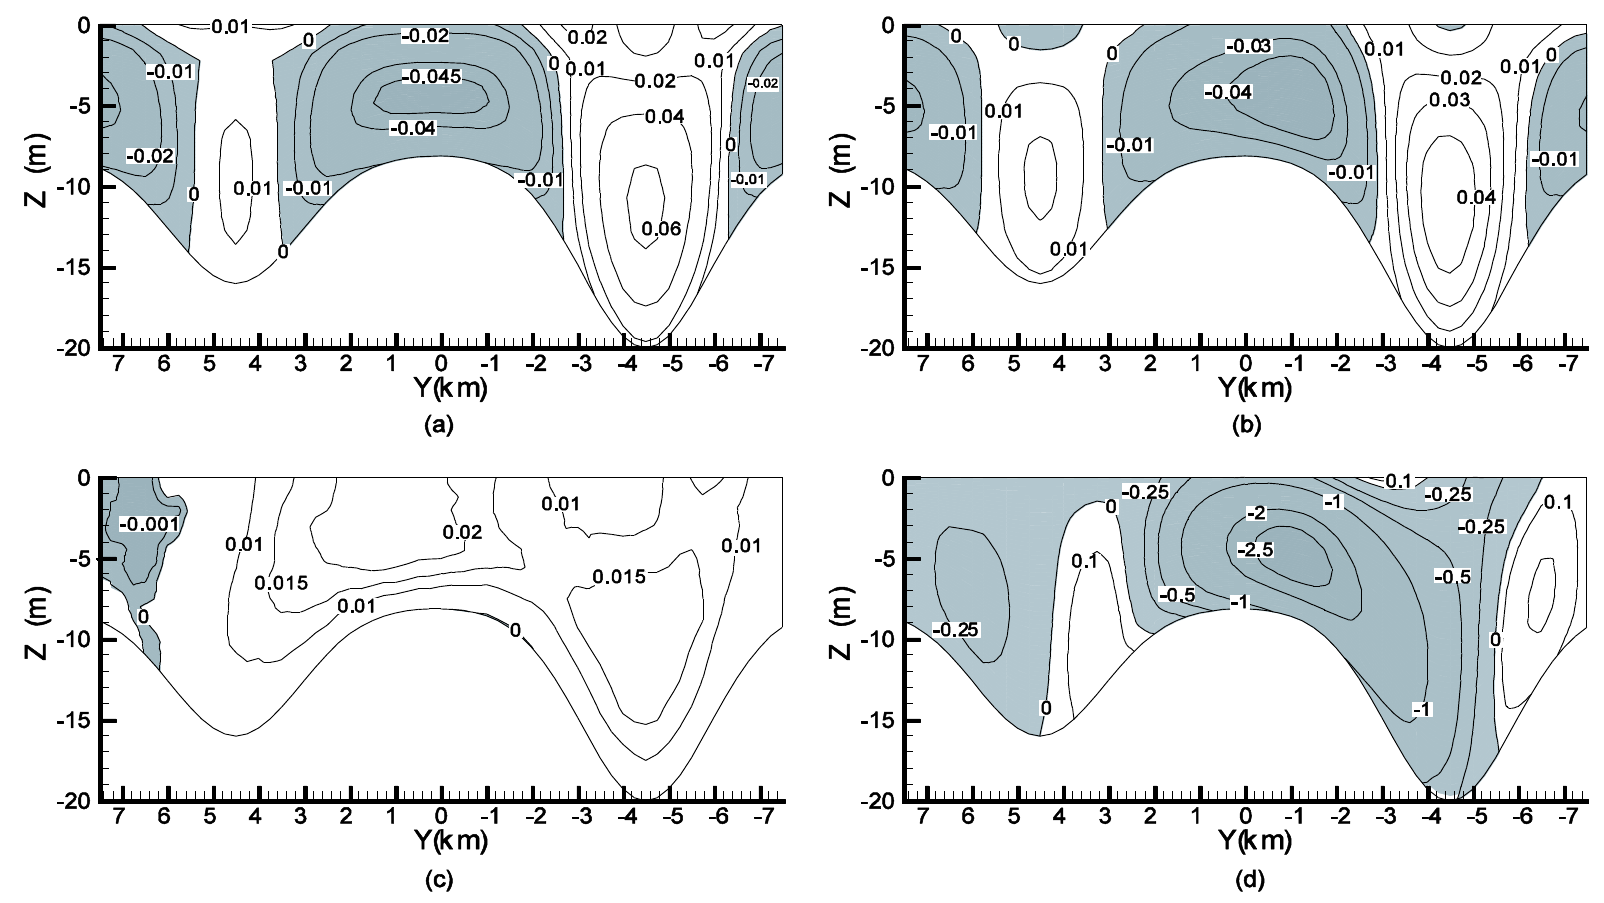
Figure 7. Contours of u x velocity (m/s) at ( a ) x = 50 km and ( b ) x = 98 km and contours of u y velocity (m/s × 10 −2 ) at ( c ) x = 50 km and ( d ) x = 98 km for the wind-density-driven case. The dark areas represent negative velocities.